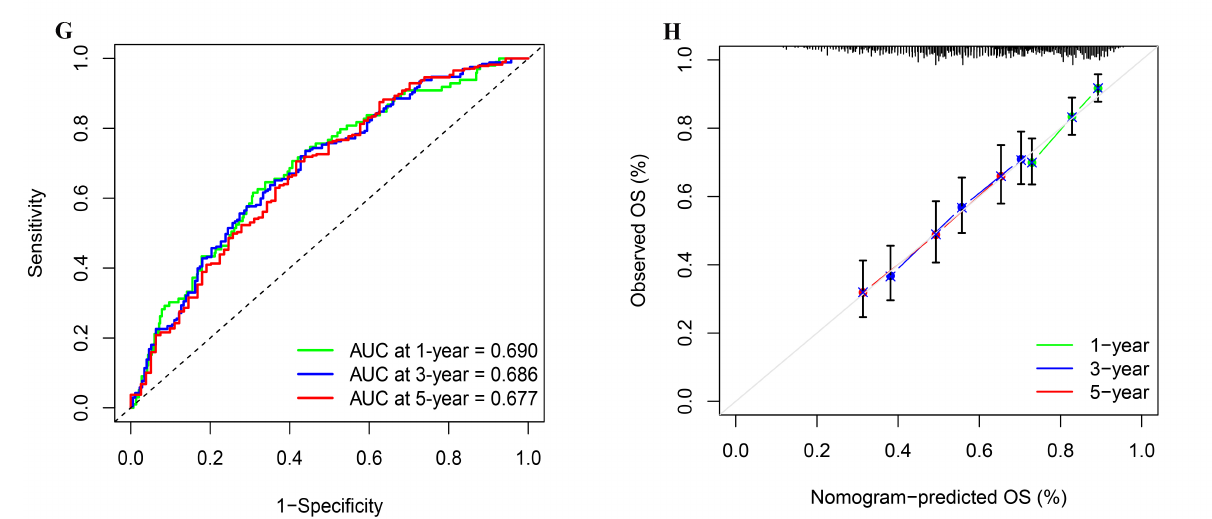
Figure 5. Construction and analysis of IRPM. ( A ) The LASSO coefficient curve drawn when the simulation parameter was set to 1000. ( B ) Cross-validation for tuning parameter selection in the LASSO model. ( C , D ) Distribution of risk score, survival time, and survival status in the combined TCGA-BLCA and GSE13507 cohorts. ( E ) Correlation analysis of OS and risk score in the combined TCGA-BLCA and GSE13507 cohorts. ( F ) Survival analysis for different risk groups in the combined TCGA-BLCA and GSE13507 cohorts. ( G ) Prediction of 1-, 3-, and 5-year ROC and AUC based on IRPM in the combined TCGA-BLCA and GSE13507 cohorts. ( H ) The calibration diagram based on IRPM in the combined TCGA-BLCA and GSE13507